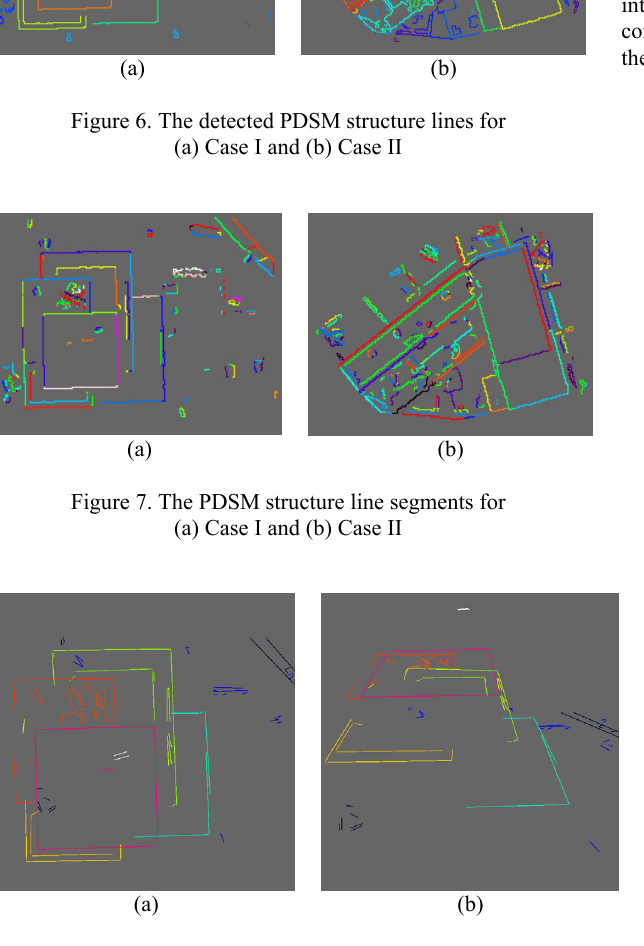
Figure 8. The 3D structure lines for Case I in (a) the first view and (b) the second view